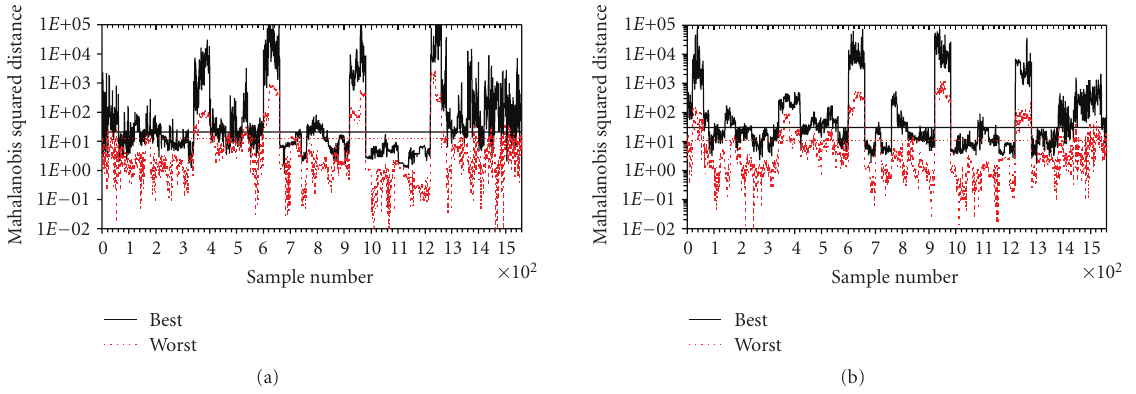
Figure 7: Test 1. Mahalanobis squared distance as a function of the sample number associated with the filtering combination that maximizes (best) and minimizes (worst) the detection of internal defects probed using (a) the gage sensors pair and high-frequency bandwidth and (b) the gage sensors pair and low-frequency bandwidth.